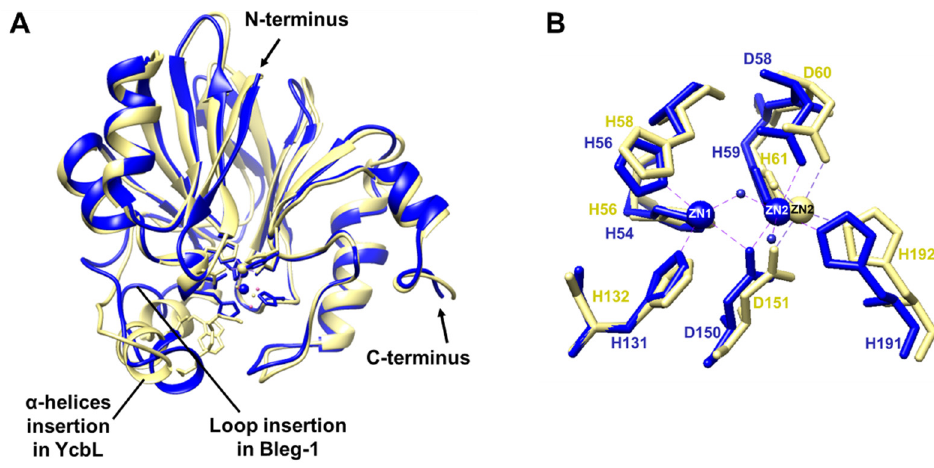
Figure 7. Superimposition of the ( A ) overall protein structure and ( B ) metal coordinating residues of BLEG-1 (blue) with YcbL (PDB ID: 2XF4, chain A) (yellow). residues of BLEG-1 (blue) with YcbL (PDB ID: 2XF4, chain A)